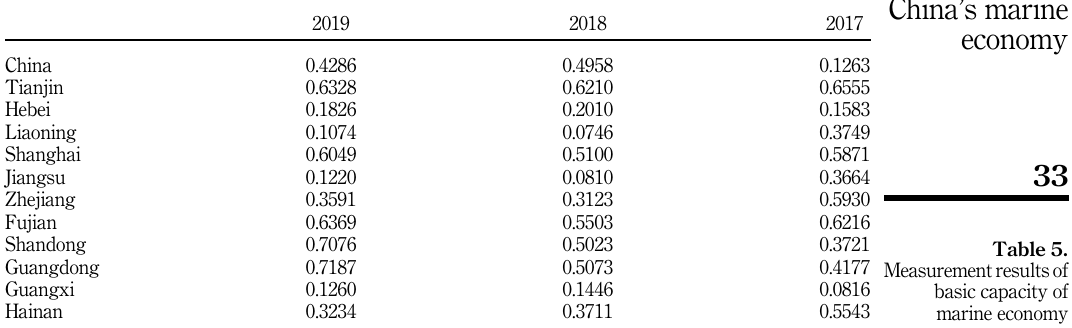
Table 5. Measurementresultsof